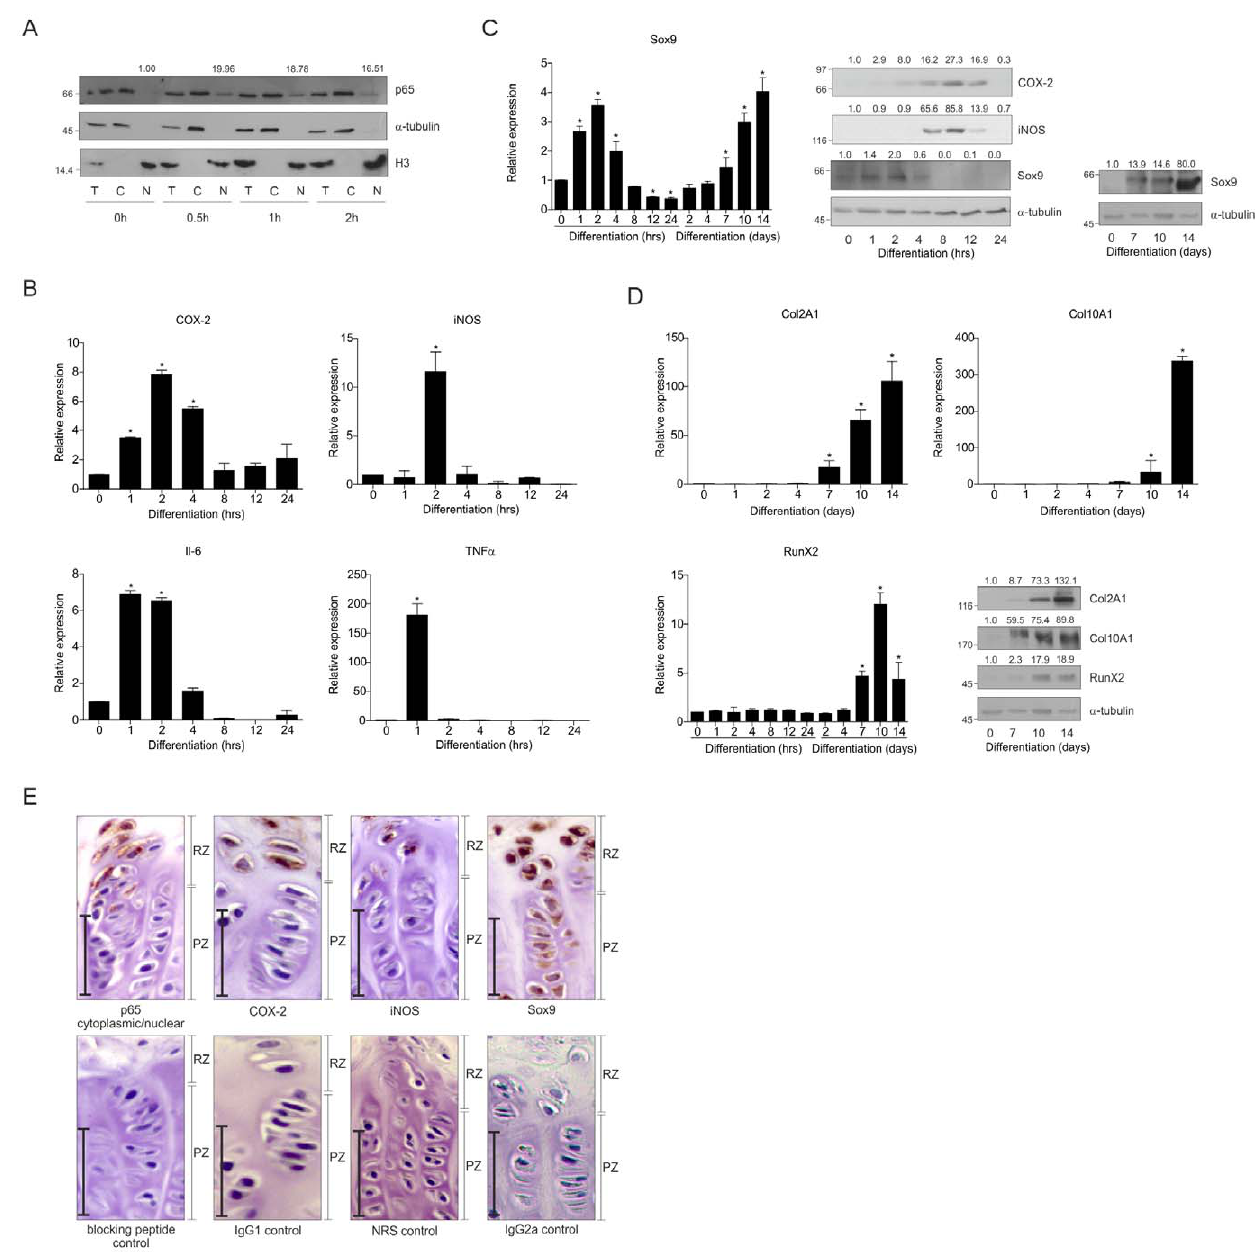
Figure 1. Early chondrogenic differentiation is accompanied by NF- k B/p65 activation and transient Sox9 expression. A: Nuclear translocation of the NF- k B subunit p65. Total extract (T), cytoplasmic (C) and nuclear (N) fractions were isolated at 0, 0.5, 1 and 2 hours in ATDC5 differentiation. Cytoplasmic marker: a -tubulin, nuclear marker: Histone H3. B: COX-2, iNOS, Il-6 and TNF a mRNA expression at 0–24 hours in differentiation (relative to t=0 and corrected for b -actin). C: Sox9 mRNA expression during chondrogenic differentiation (left panel). Protein expression of Sox9, COX-2 and iNOS at 0–24 hours (middle panel) and for Sox9 also at 0, 7, 10 and 14 days in differentiation (right panels). Molecular weight markers (kDa) are depicted on the left of immunoblots and relative quantifications are depicted on top of immunoblots. *=p , 0.05. D: mRNA and protein expression of Col2A1, Col10A1, RunX2 during ATDC5 differentiation E: Sections from 6 weeks old mouse growth plates (resting (RZ) and proliferative (PZ) zones) stained for p65, COX-2, iNOS and Sox9. Lower panels show appropriate negative controls. Bars=50 m